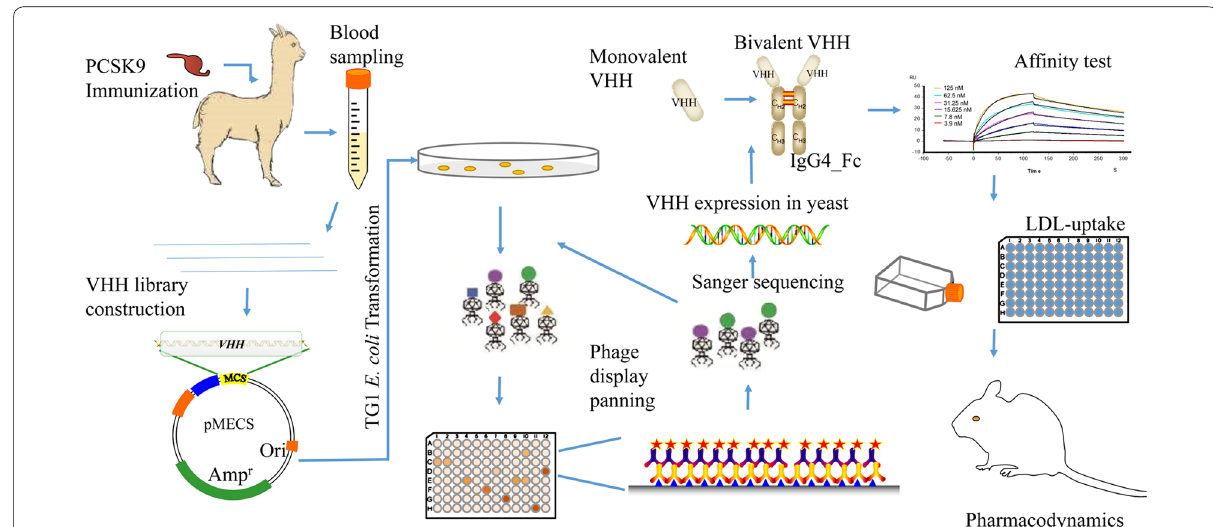
Fig. 1 Schematic diagram of the whole experimental workflow. The whole experimental workflow consists of the PCSK9 immunization, blood sampling, VHH library construction, E. coli transformation, phage-display panning, Sanger sequencing, VHHs protein expression, bivalent VHH design, affinity test, LDL-uptake, and pharmacodynamics